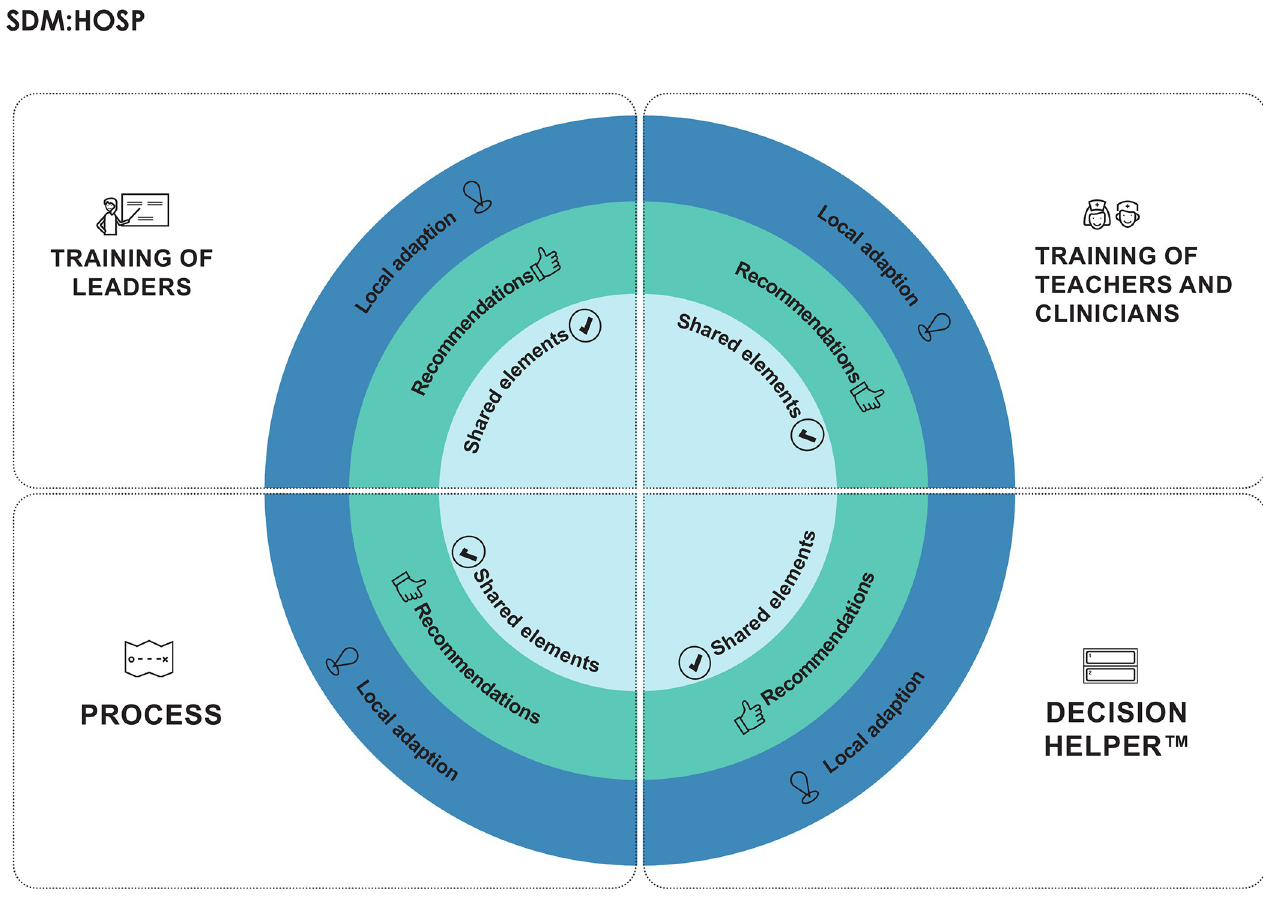
Fig 6. The final model